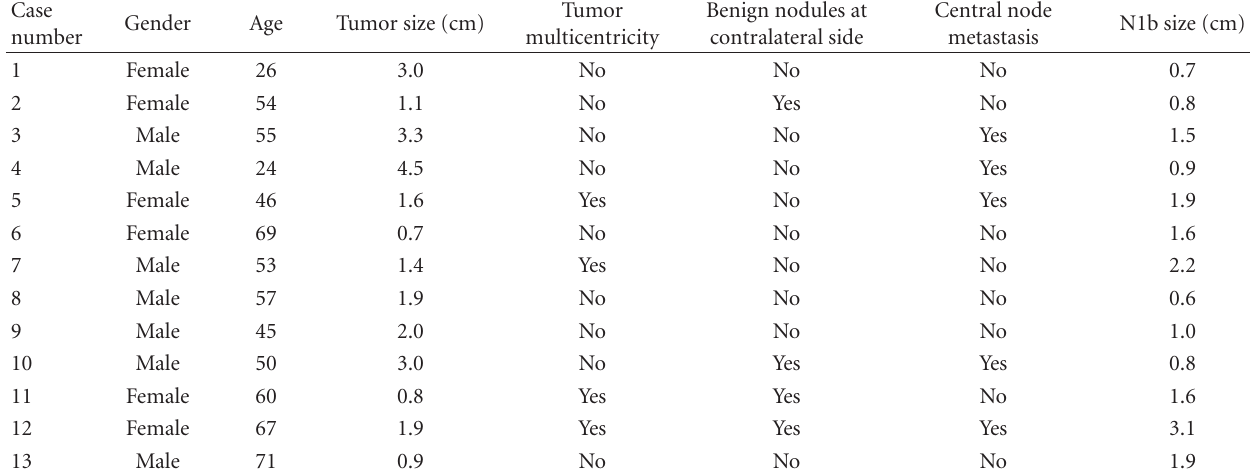
Table 1: Backgrounds and preoperative evaluation of 13 patients with contralateral but not ipsilateral N1b. Case